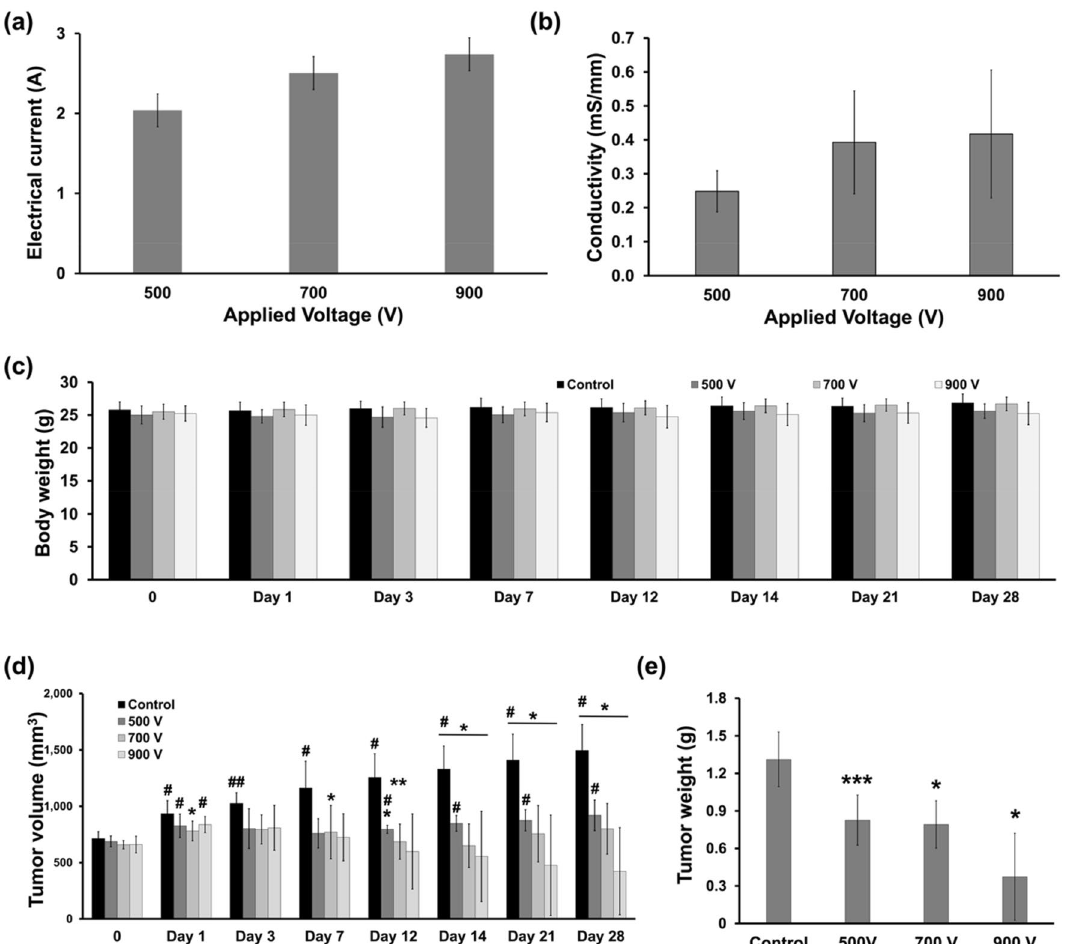
Figure 2. Safety measures of the irreversible electroporation procedure. ( a ) Electrical current and ( b ) change in conductivity increased proportionally with the applied voltages. ( c ) The body weight did not significantly change in any of the groups. ( d ) Except for the control group in which the tumor volume kept increasing, all the treatment groups experienced an increase and then a decrease in the tumor volume. The 900 V group seemed